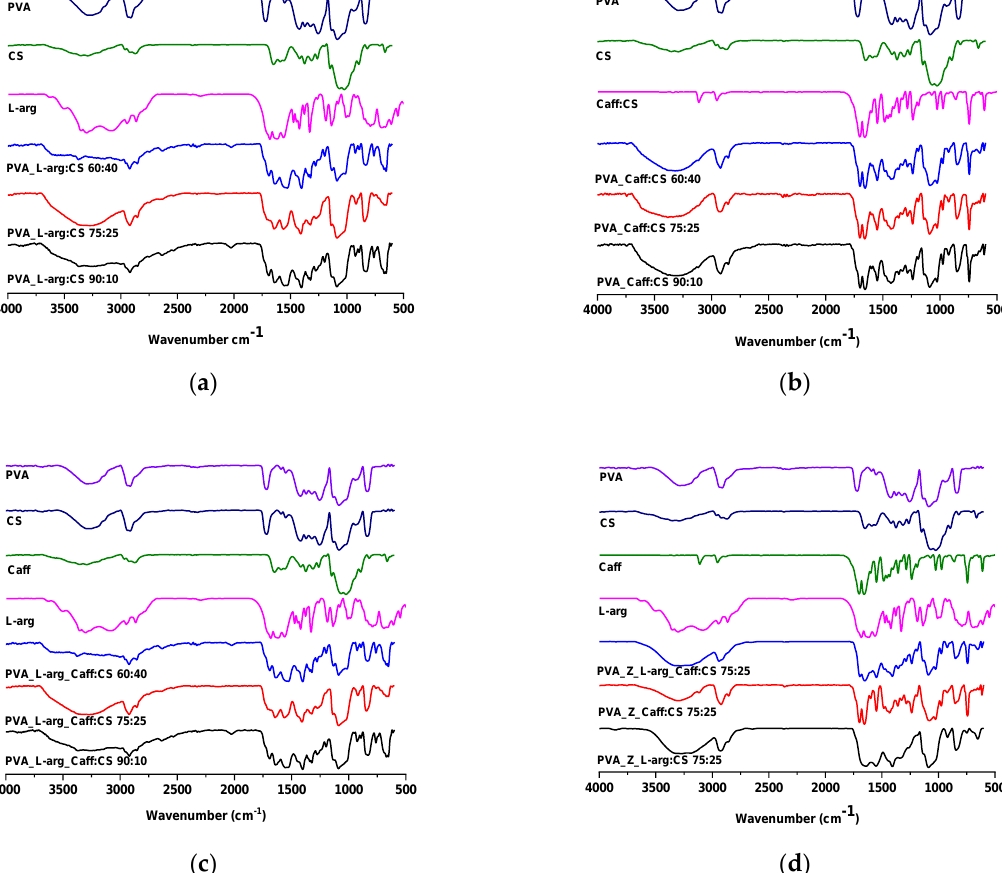
Figure 1. FT-IR spectra of hydrogels ( a ) loaded with L-arginine; ( b ) loaded with caffeine; ( c ) loaded with L-arginine and caffeine mixture, and ( d ) containing zeolite.